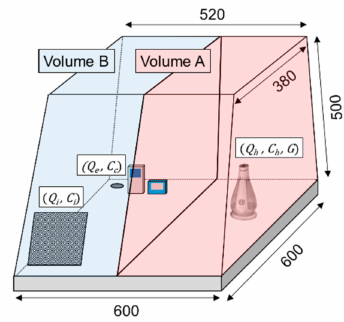
Figure 2. Variables of the calibration